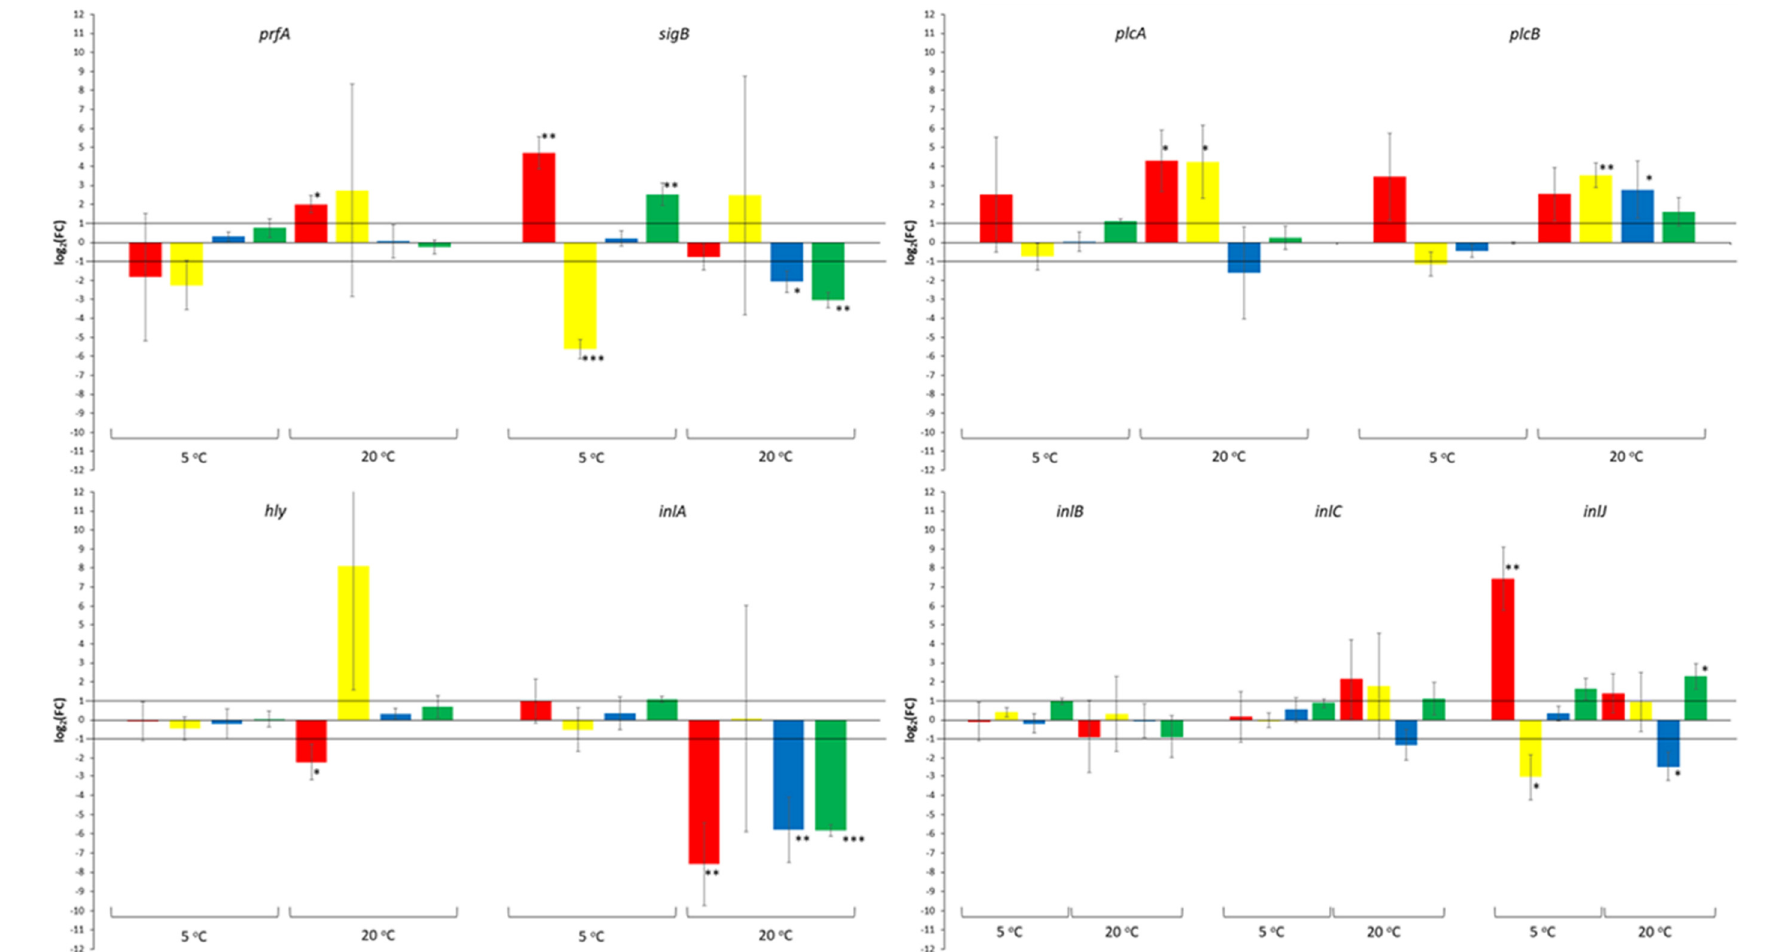
Figure 2. Effect of incubation time on the relative transcription of prfA , sigB , hly , plcA , plcB , inlA , inlB , inlC and inlJ , during growth of L. monocytogenes strain LQC 15257 in monoculture (red bars) and in coculture with S. cerevisiae strains Y32 (yellow bars), Y34 (blue bars) and Y37 (green bars). Growth of the pathogen in mono-or co-culture for 24 h was used as control. Error bars represent the standard deviation of the mean value. Presence of asterisks indicates that the relative transcription was above 1 or below − 1 (the values that were used as threshold) at p value indicated by the number of asterisks (* p < 0.05; ** p < 0.01; *** p < 0.001).